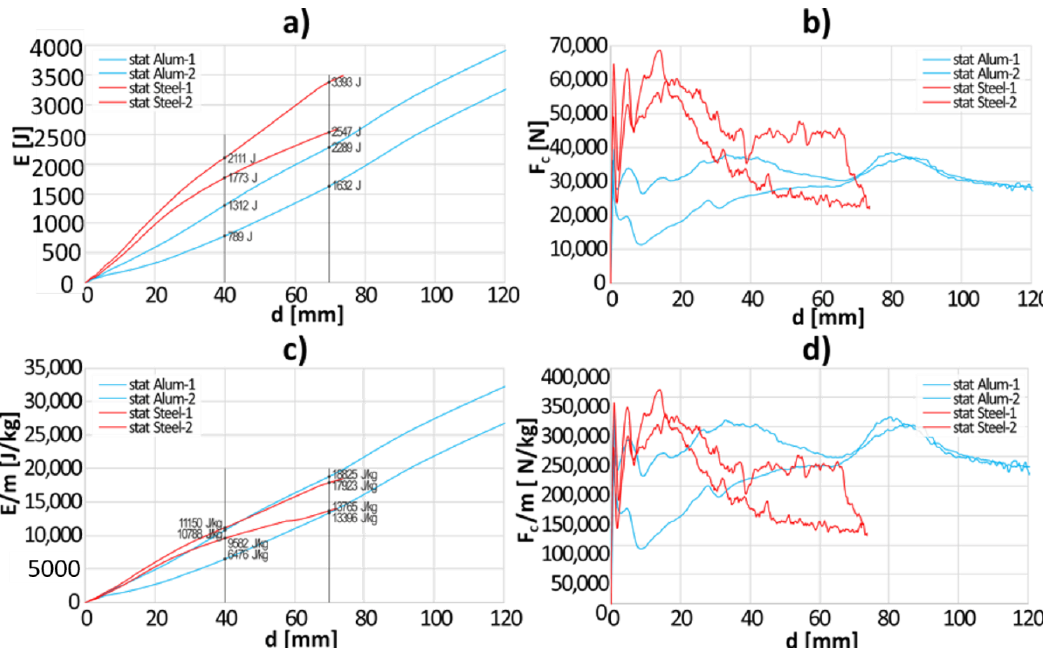
Figure 4. The results of quasi-static compression tests: ( a ) E = f(d); ( b ) F C = f(d); ( c ) E /m = f(d); ( d ) F C /m = f(d).